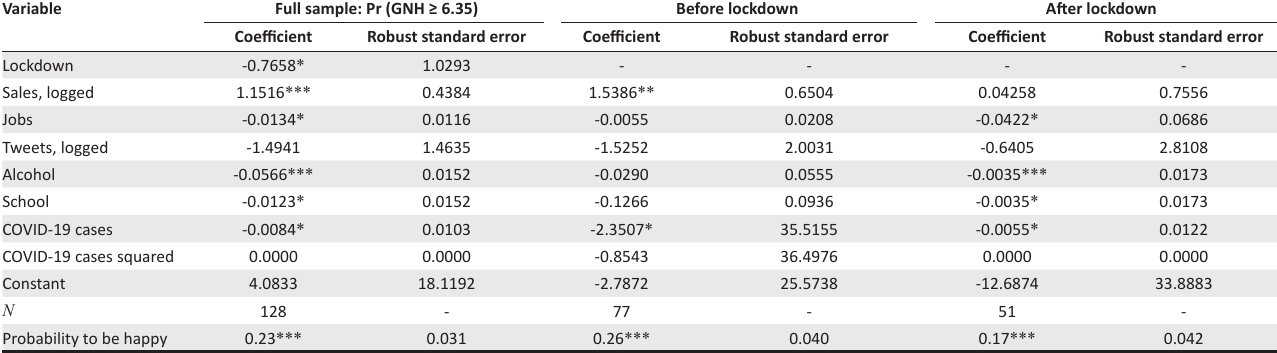
TABLE 3: Probit estimations on the probability to be happy.